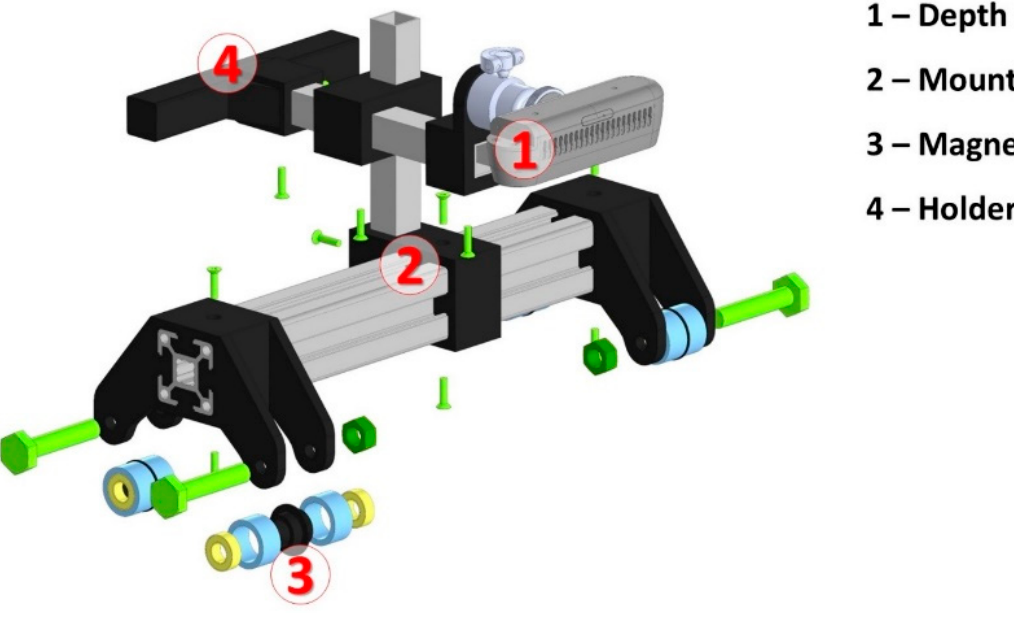
Figure 4. A 3D mechanical prototype model with an installed RGB-Depth camera and magnetic wheels.